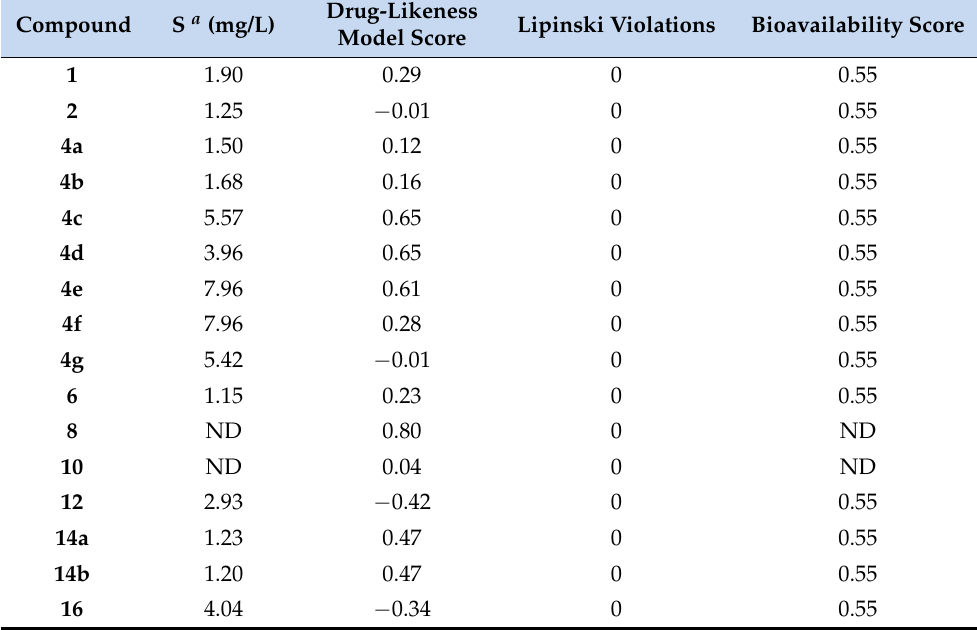
Table 3. Lipinski drug-likeness of compounds 1 , 2 , 4a – g , 6 , 8 , 10 , 12 , 14a , 14b , and 16